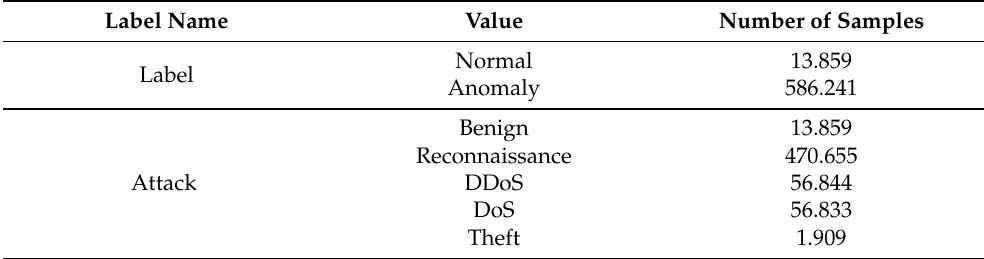
Table 2 lists the NF-BoT-IoT distribution of all flows. Table 2. NF-BoT-IoT-v2 dataset